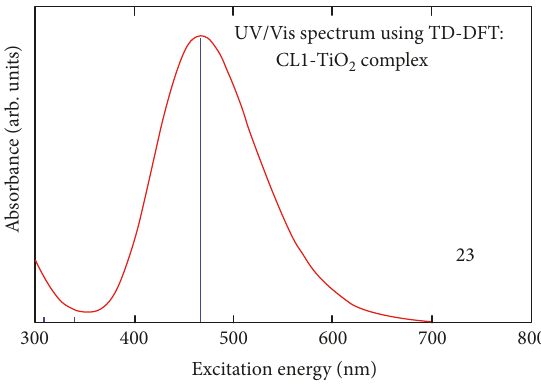
Figure 11: UV/Vis spectrum using TD-DFT of CL1-TiO calculated within the CAM-B3LYP approximation, showing individual transitions as impulses with maximum absorbance values of 436.0nm and 467.4nm.